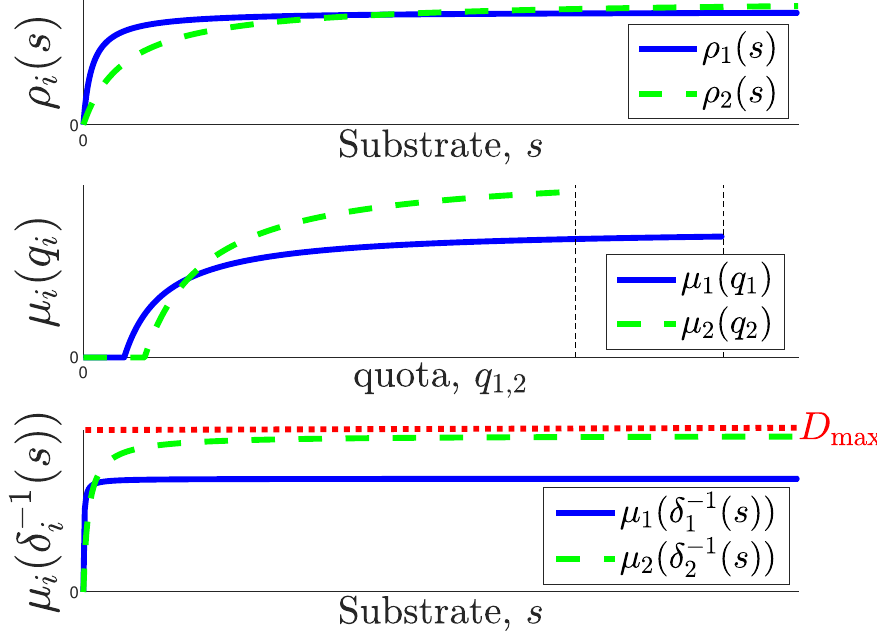
Figure 1. The illustrated absorption functions ρ i and growth rates µ i lead to a generic form of the actual growth rates s (cid:55)→ µ i ( δ i ( s )) where both species may win the competition. The maximum dilution rate D max is a fixed constant value above the maximum of the functions s (cid:55)→ µ i ( δ i ( s )) for i = 1,2, as stated in Assumption